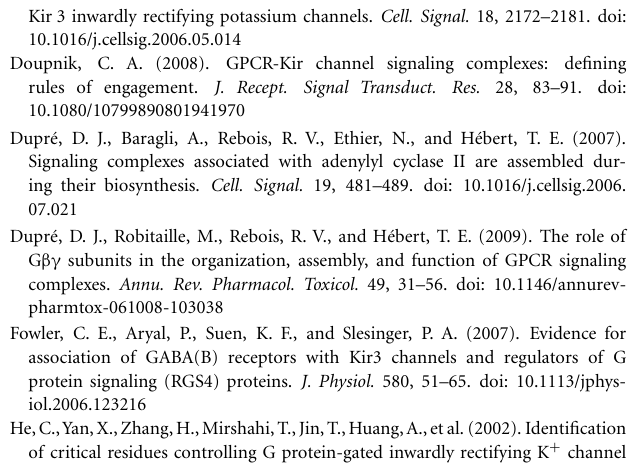
FIGURE 6 | Distinct G βγ effects on Kir3 stability. Under normal conditions, pulse induction of Kir3.1 expression in the presence of Kir3.2 forms heterotetrameric channels of mature Kir3.1 and Kir3.2 (light green), which can traffic to the cell surface and remain expressed at the plasma membrane for up 48 h. siRNA mediated knockdown of G β 1 or G γ 2 has negligible effects on immature Kir3.1 channels (dark green) but impairs Kir3.1 maturation and hastens the loss of channel at the cell surface suggesting a stabilizing roles for the G β 1 γ 2 dimer. These effects of G β 1 γ 2